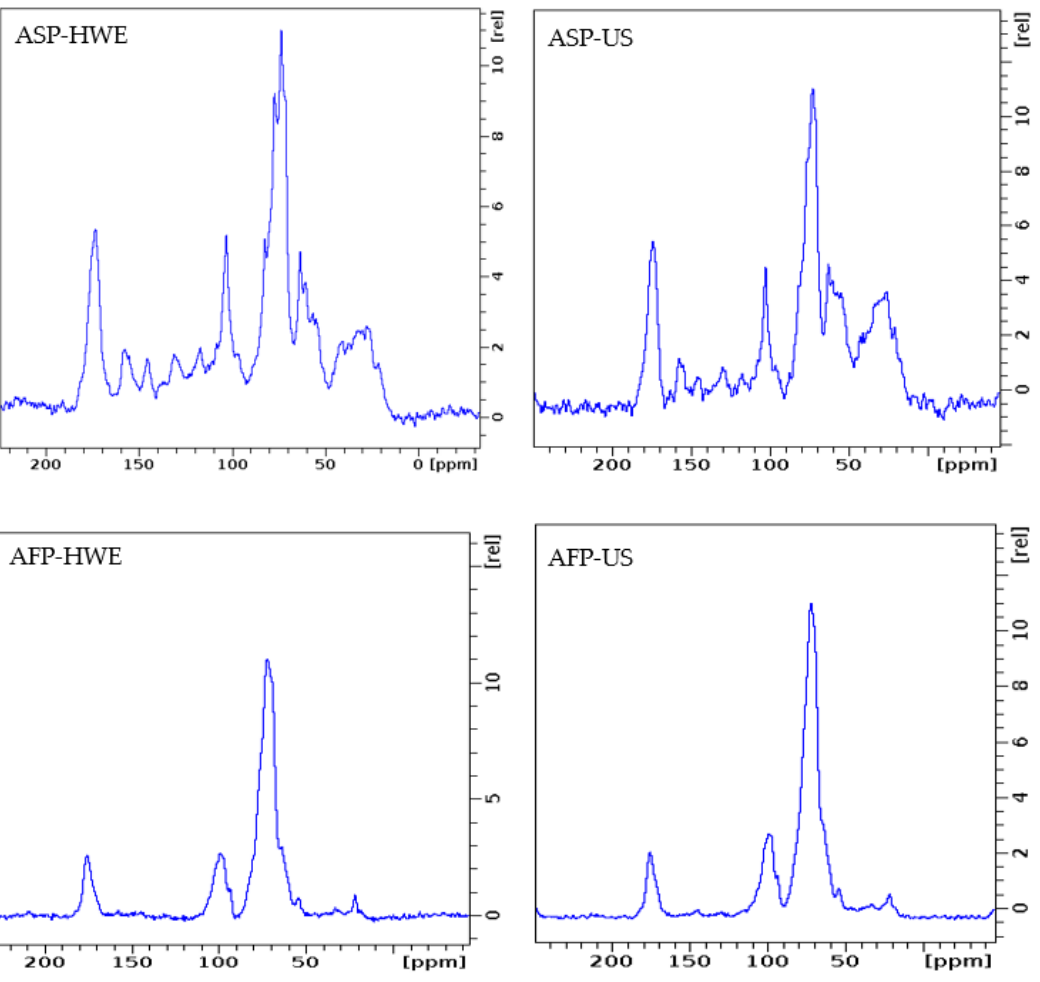
Figure 2. The 13 C NMR spectra of polysaccharides extracted from Ajwa seed (ASP) and flesh (AFP) by hot water extraction (HWE) and ultrasonic extraction (US).